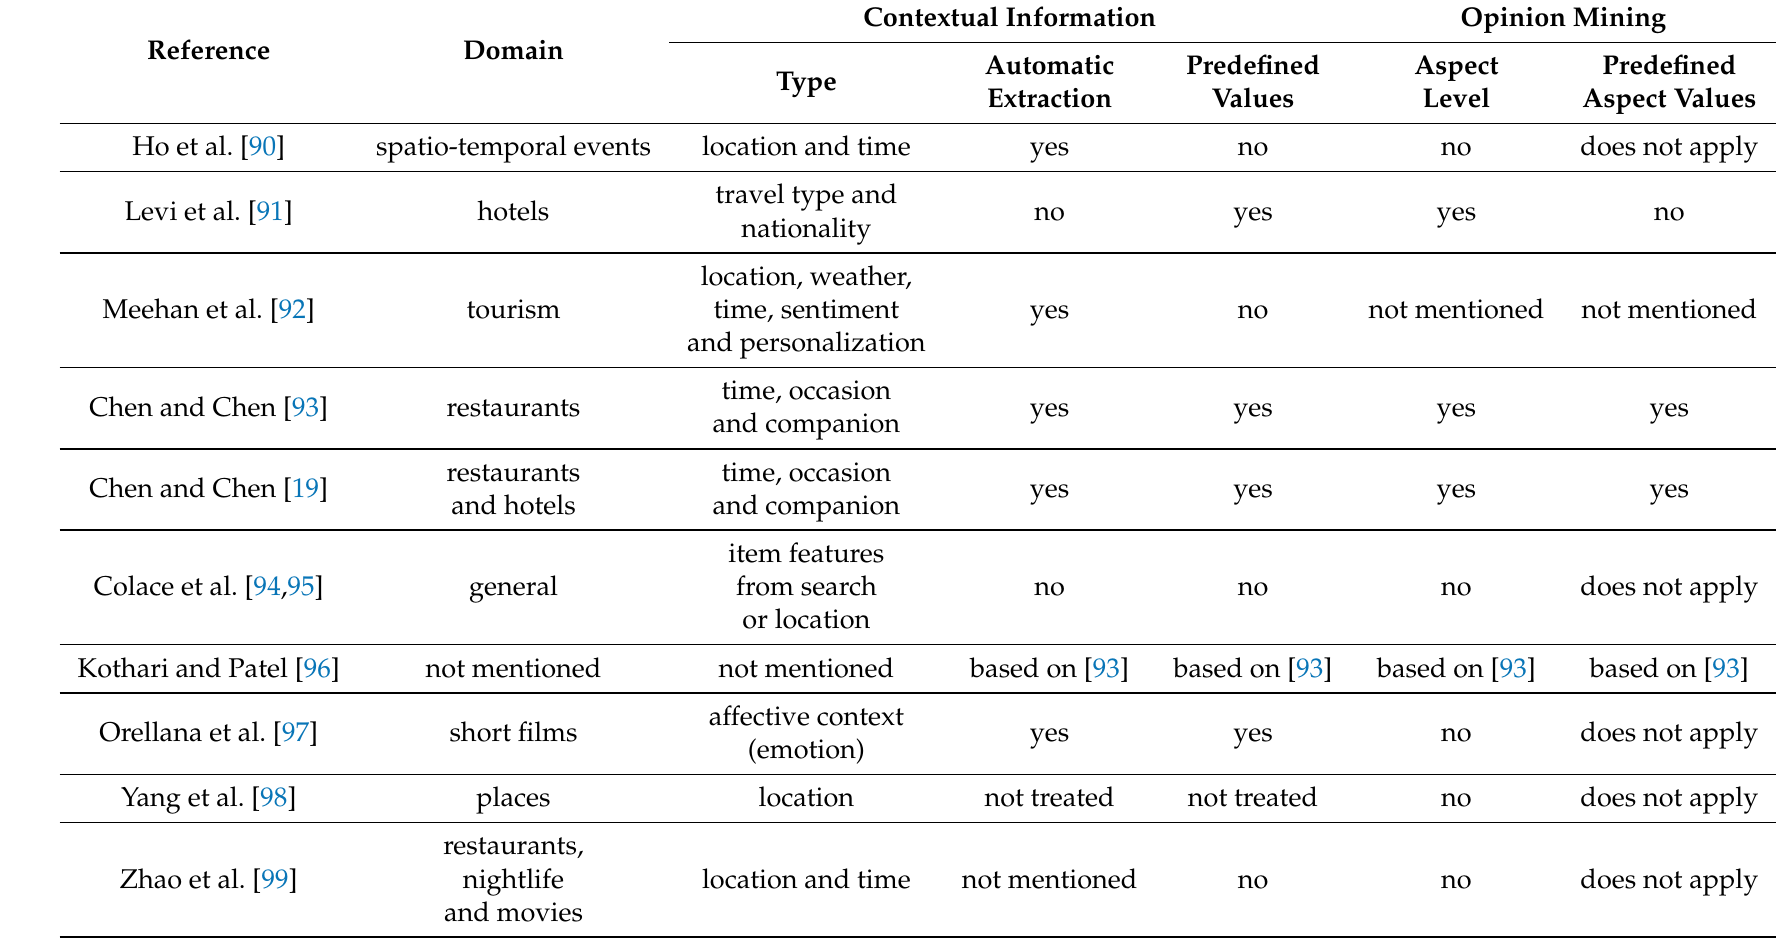
Table 1. Summary of works on context-aware recommender systems using opinion